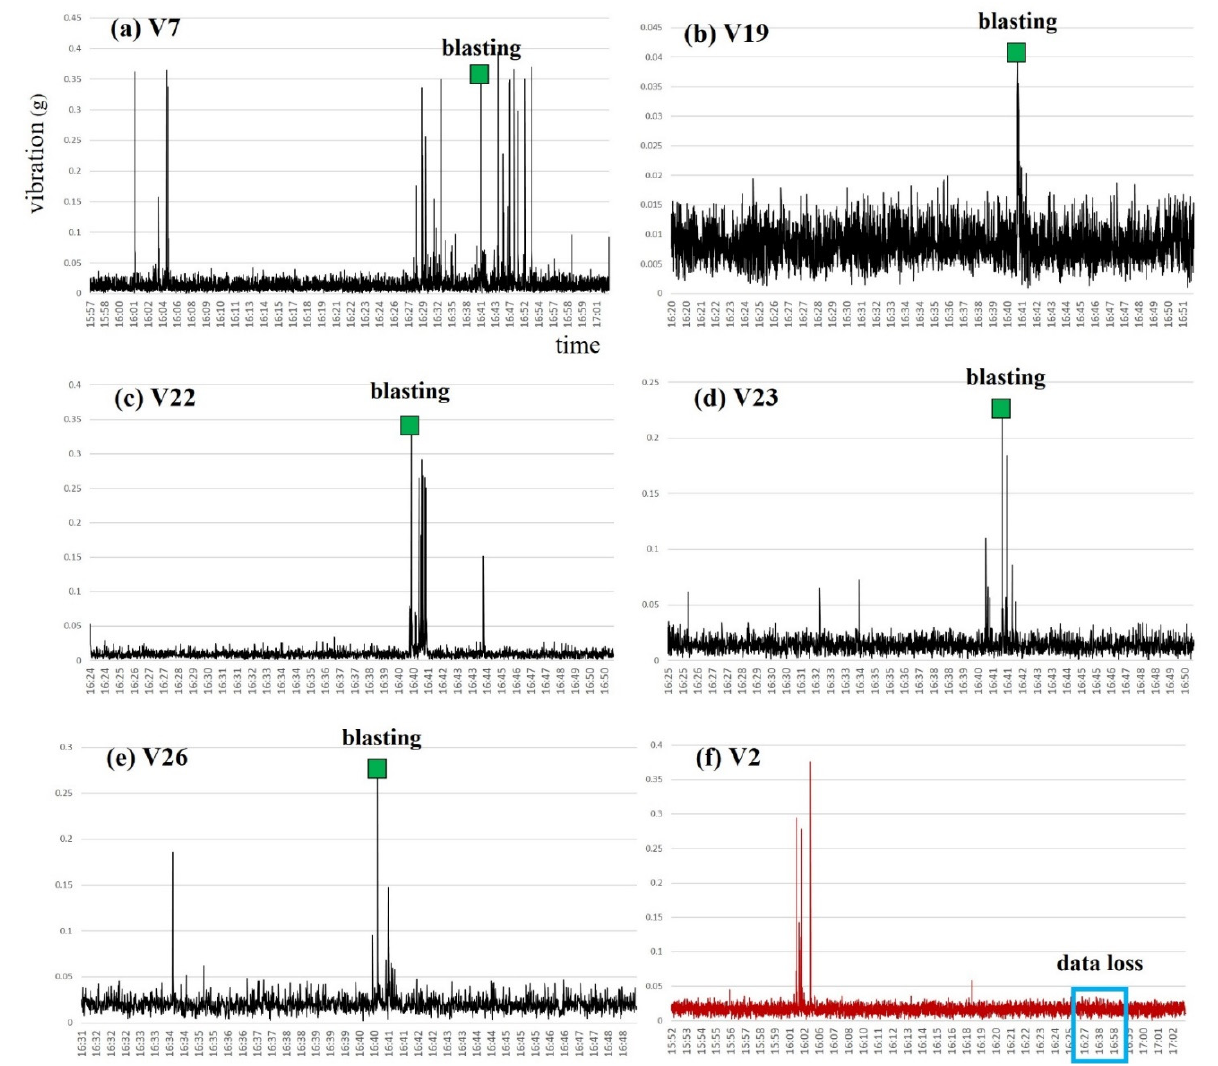
Figure 7. Graph of modules ( a ) V7, ( b ) V19, ( c ) V22, ( d ) V23, and ( e ) V26, where vibration was detected after blasting; and ( f ) graph of module V2 with missing data.